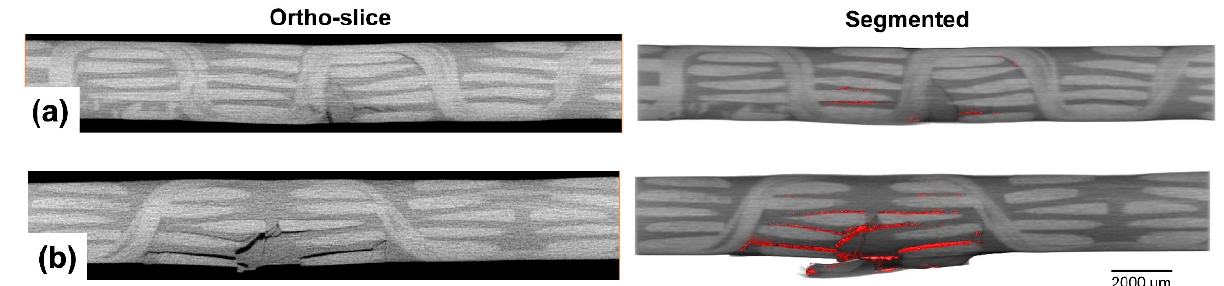
Figure 9. Ortho-slices and segmented damage highlighted in red in locations where there exist binding yarns in the 3D woven composites (the top is the front side of the impact and the bottom is the backside) for: ( a ) ORT-PW and ( b ) ORT-TW.